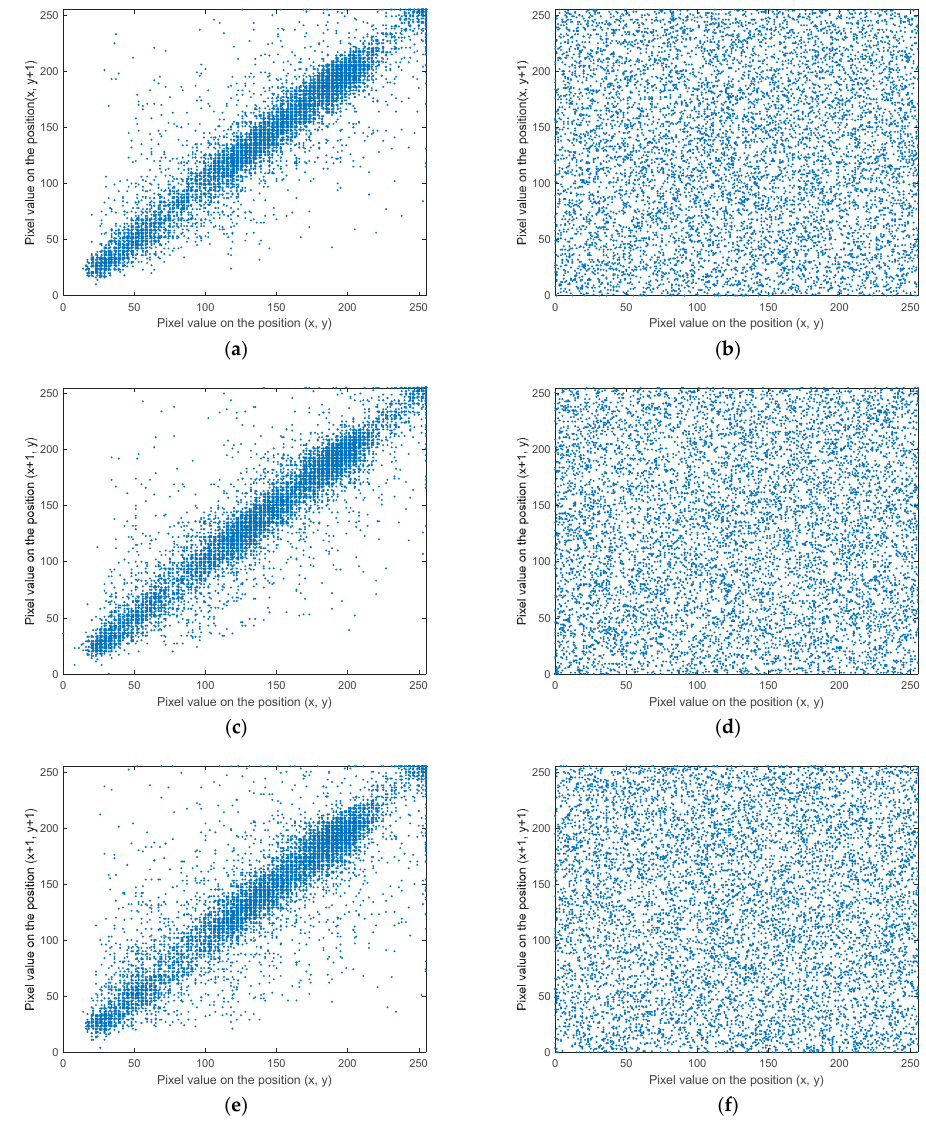
Figure 6. Pixel relevance of Figure 4a,b: ( a ) horizontal direction in Figure 4a; ( b ) horizontal direction in Figure 4b; ( c ) vertical direction in Figure 4a; ( d ) vertical direction in Figure 4b; ( e ) diagonal direction in Figure 4a; and ( f ) diagonal direction in Figure 4b.